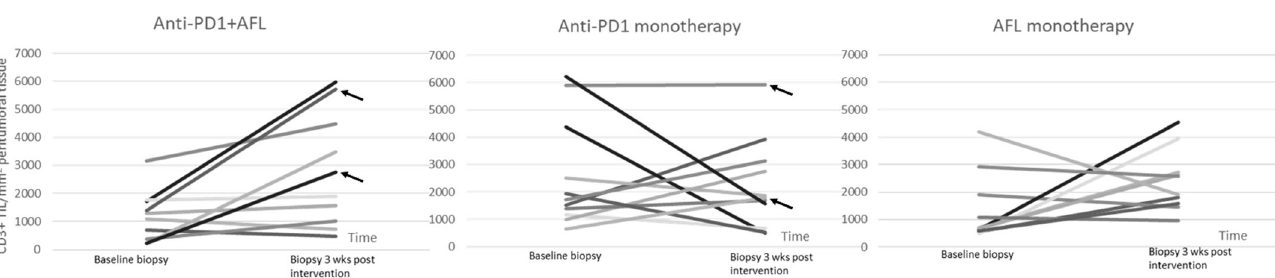
resents one BCC with the slope indicating increase or decrease in CD3+ T ‐ cells before and after in ‐